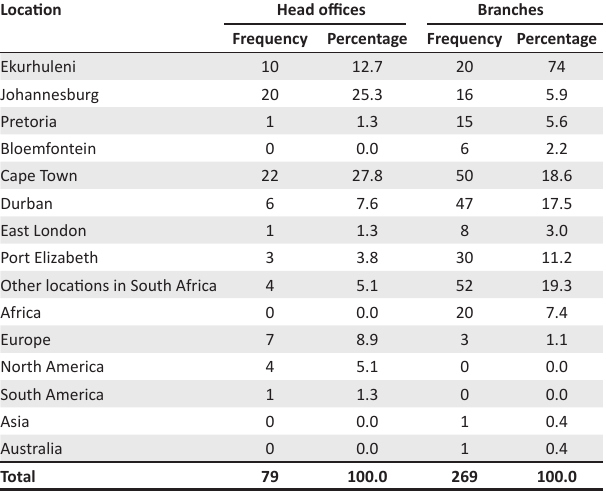
TABLE 2: Location of O.R. Tambo airport-centric development’s head offices and branches.